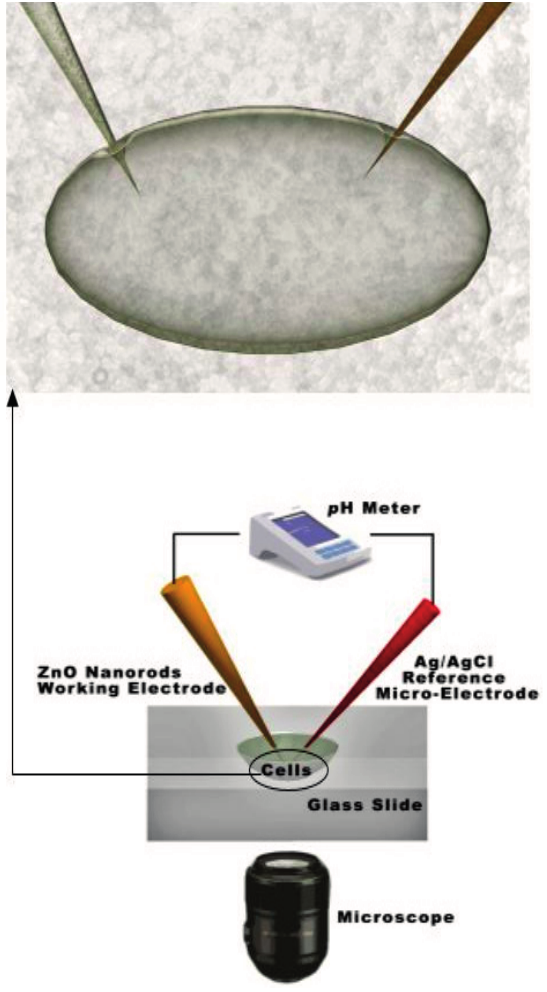
Figure 2. Schematic experimental setup for the intracellular potentiometric measurements. In the human body, the hormone insulin only stimulates glucose transport into muscle and fat